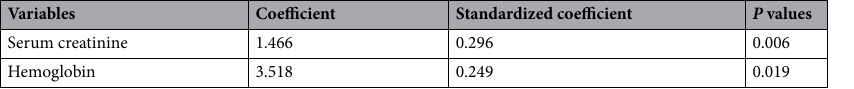
Table 3. Multiple linear regression analysis of independent factors of access-hand rSO 2 after PTA.